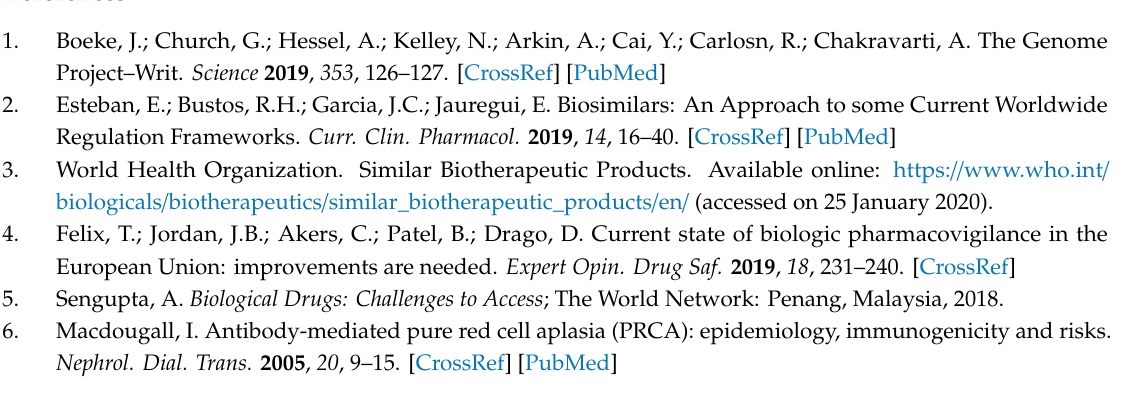
Table S1: Approved biotherapeutics for rheumatic diseases, Table S2: Case series studies and case reports, Table S3: Adverse events in rheumatic diseases presented in cross-sectional studies, Table S4: Adverse biotherapeutic events in rheumatic diseases presented in case-control studies, Table S5: Adverse biotherapeutic events in rheumatic diseases presented in cohort studies (presented by percentages), Table S6: Adverse biotherapeutic events in rheumatic diseases presented in cases by 1000 patients /